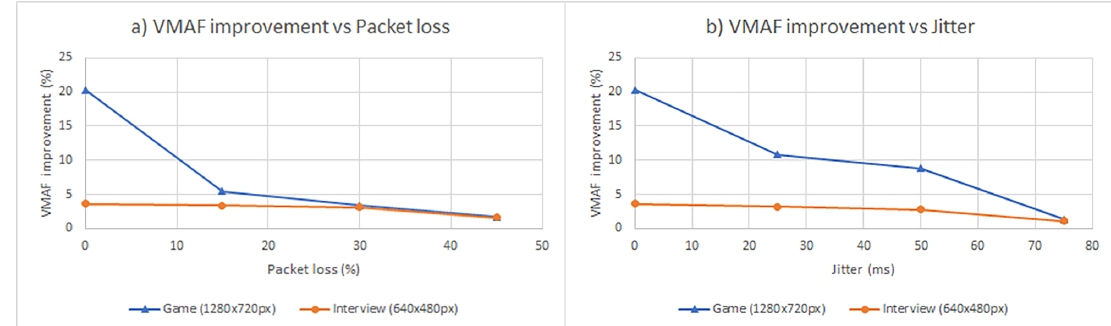
Figure 6. Level of improvement in VMAF (in percentage) comparing the impairment sequences (game and interview) before and after the alignment process. ( a ) VMAF improvement using different scenarios of packet loss. ( b ) VMAF improvement using different scenarios of